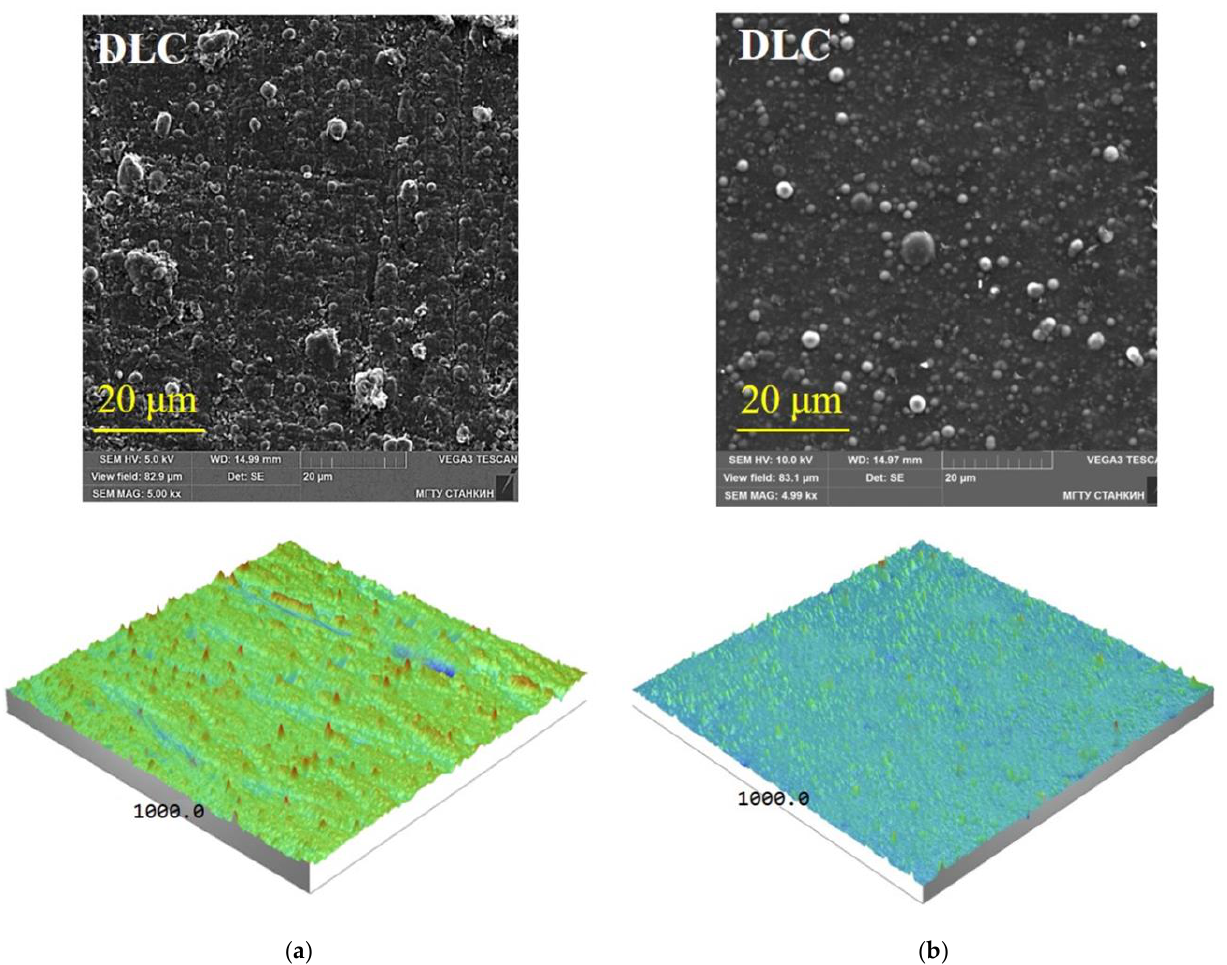
Figure 12. SEM images of the microstructure (top) and 3D profilograms (bottom) of (CrAlSi)N/DLC coatings deposited on SiAlON ceramic inserts with different surface layer conditions: ( a ) after diamond grinding; ( b ) after diamond grinding, lapping, and polishing.